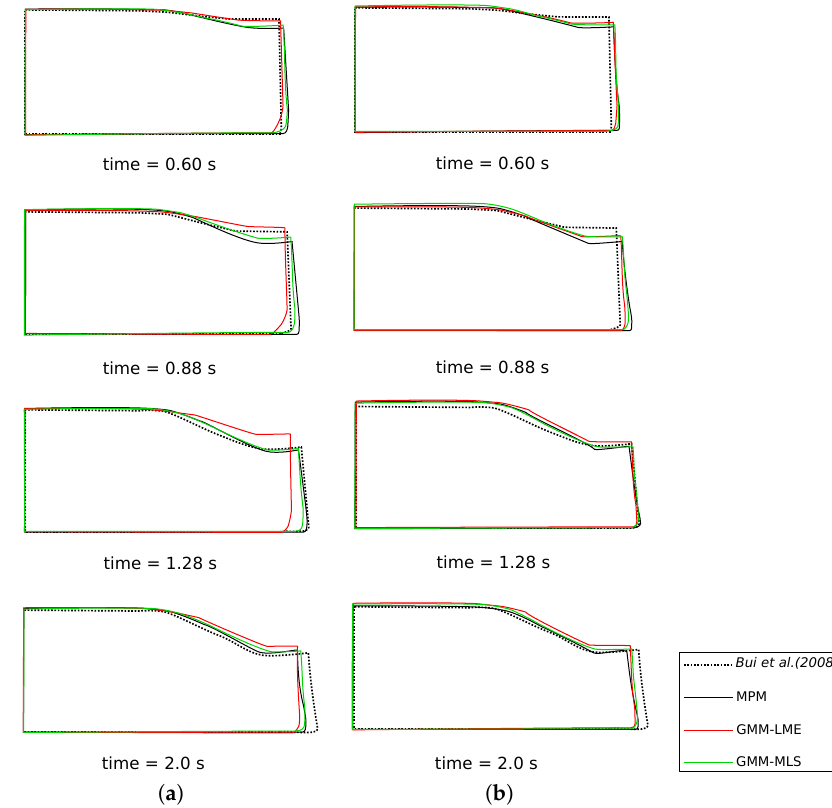
Figure 10. Soil column collapse. Configurations of the column at different representative time instants. ( a ) Mesh 1; ( b ) Mesh 2